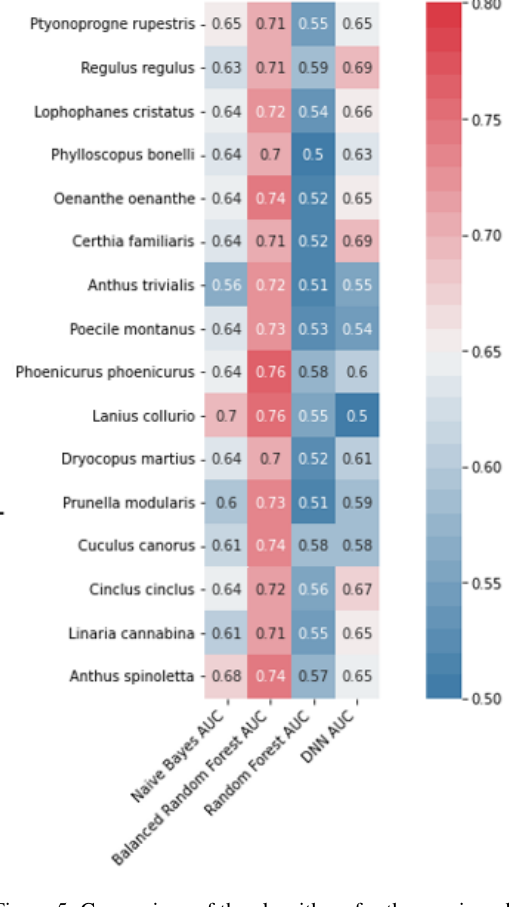
Figure 5. Comparison of the algorithms for the species where NB, RF, and DNN have AUC below 70%, Balanced-RF performs better for such species